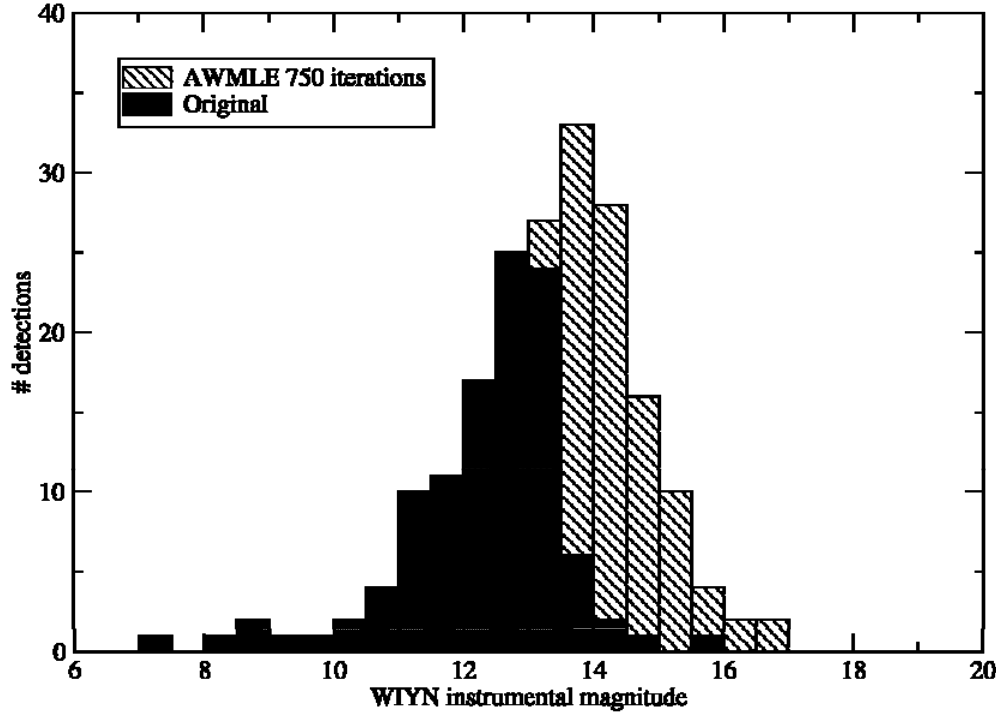
Figure 3. Magnitude histograms of matched detections for the original image and the AWMLE deconvolution at convergence of a QUEST image. Dashed area stands for the newly detected